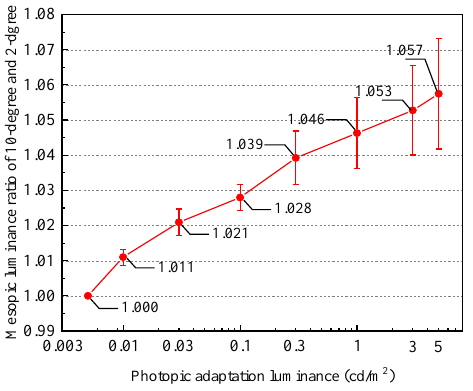
Figure 6. Mesopic luminance ratio using 10- and 2-degree light source SSCs at photopic adaptation luminance values from 0.005 to 5 cd/m 2 .